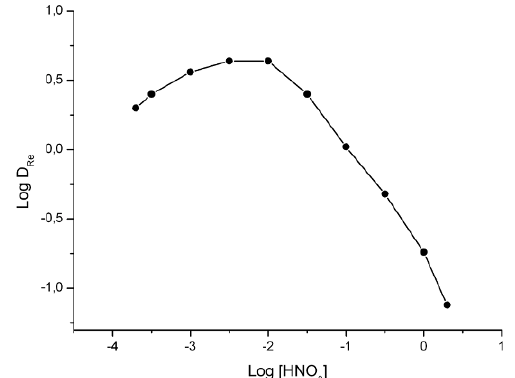
Figure 8. The effect of HNO concentration in the aqueous 3 phase on the extraction of Re(VII) by 2×10 -4 M solution of compound 1 in 1,2-dichloroethane.